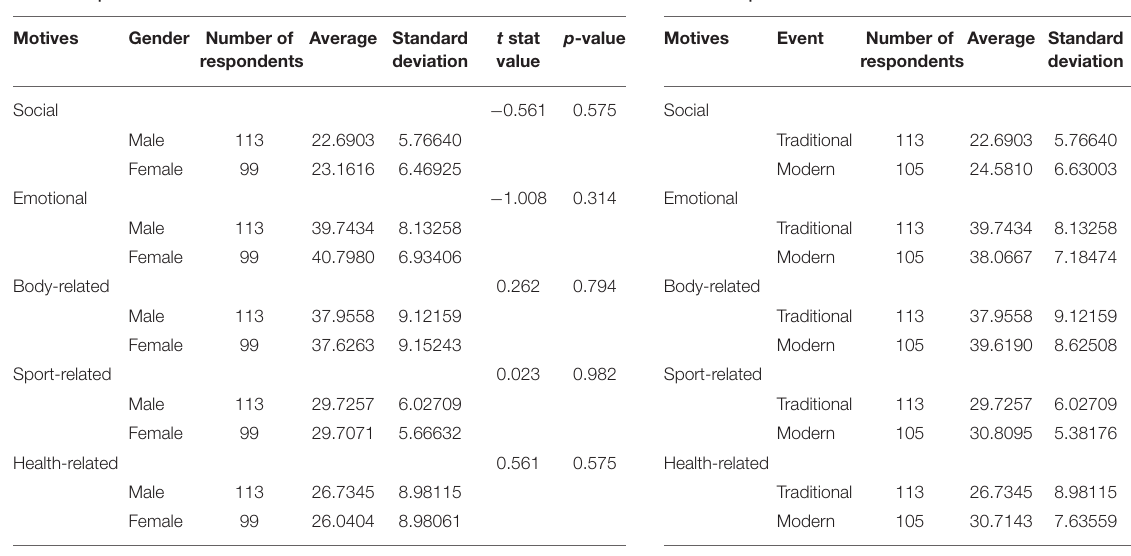
TABLE 18 | Traditional events vs. modern events – men.